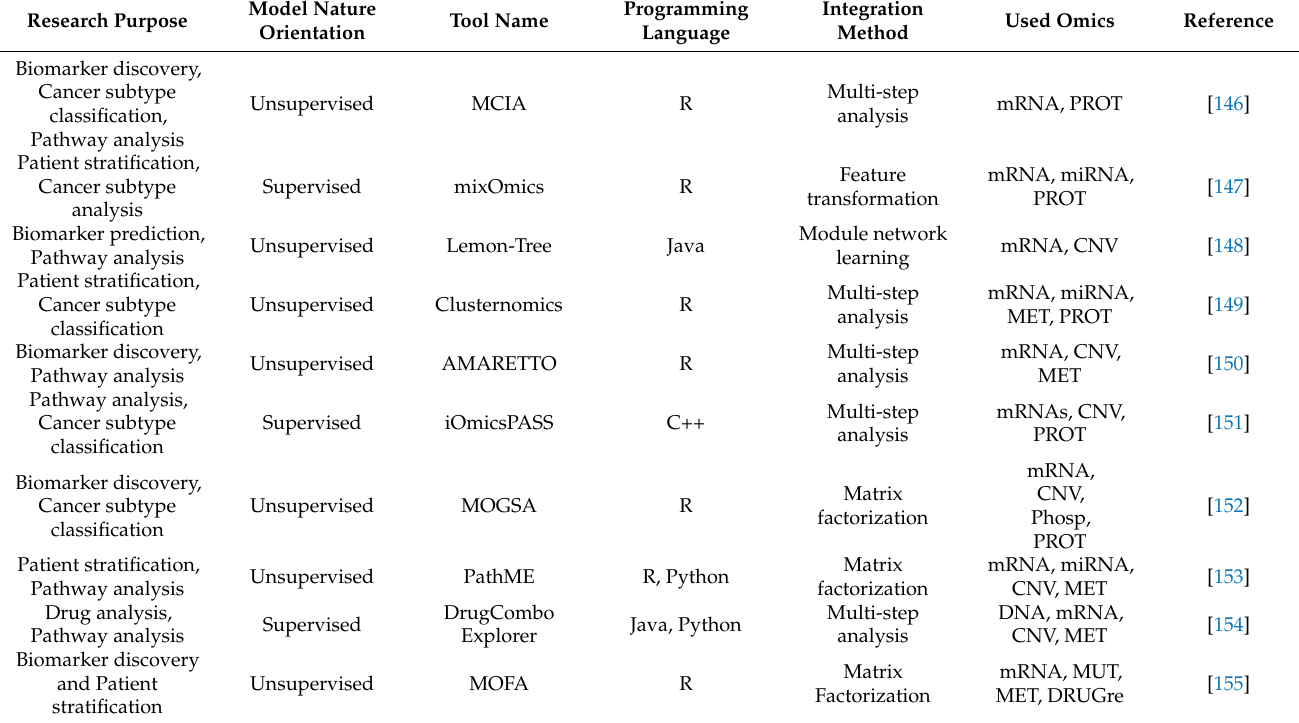
Table 7. Summary of computational methods which can be applied to several mentioned research aims in a multi-omics